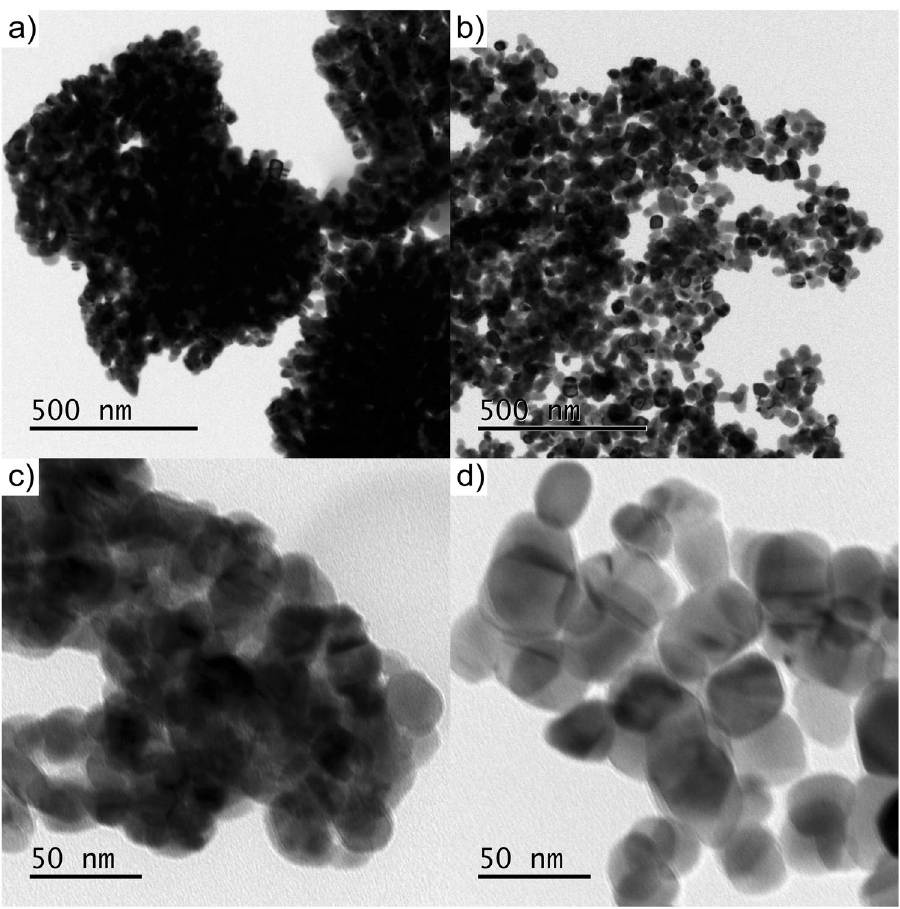
Figure 6. TEM images of the agglomerated CuO aggregates, as obtained after synthesis at ( a , c ) pH = 5.6 and ( b , d ) pH = 7.0. Except for the pH, all other synthesis parameters were taken as described in the material synthesis